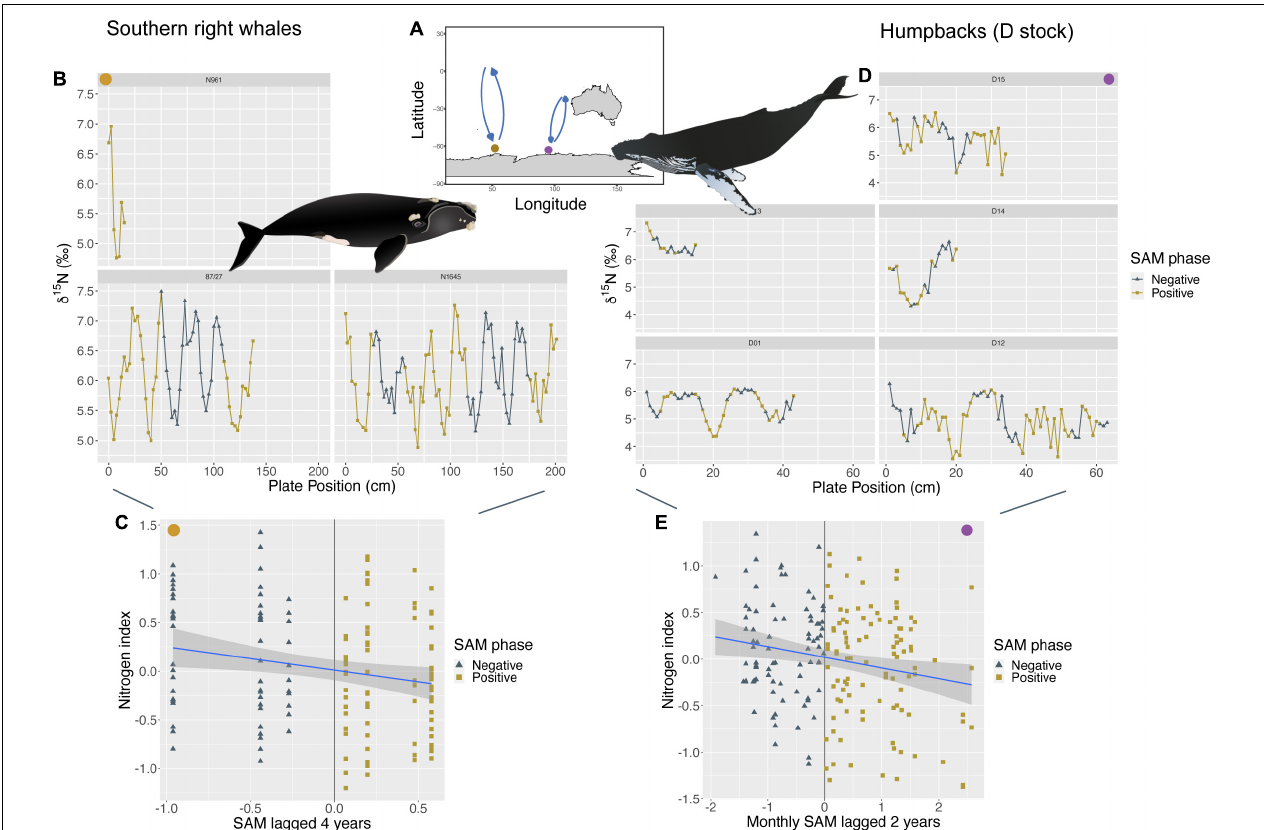
FIGURE 3 | (A) The brown circle represents an approximate feeding location of southern right whales (SRW) from the South African population (Southwest Indian Ocean, n = 3, sample points = 144). While the light purple circle represents an approximate feeding location for humpbacks from the D breeding stock (Southeast Indian Ocean, n = 6, sample points = 184). (C,E) Show a negative linear relationship between their nitrogen index and SAM, however, SRW (C) at a 4-year lag ( p < 0.05; R 2 m = 0.04) and D humpbacks (E) at a monthly 2-year lag ( p < 0.01; R 2 m = 0.04). (B,D) Show where these changes in SAM phases occur along baleen and resulting stable isotope patterns of δ 15 N for each individual. Individual “D11” was removed from the image based on having a short baleen length. Humpback whale image attribution: Tracey Saxby, Integration and Application Network (ian.umces.edu/media-library). SRW image attribution: Jamie Testa, Integration and Application Network